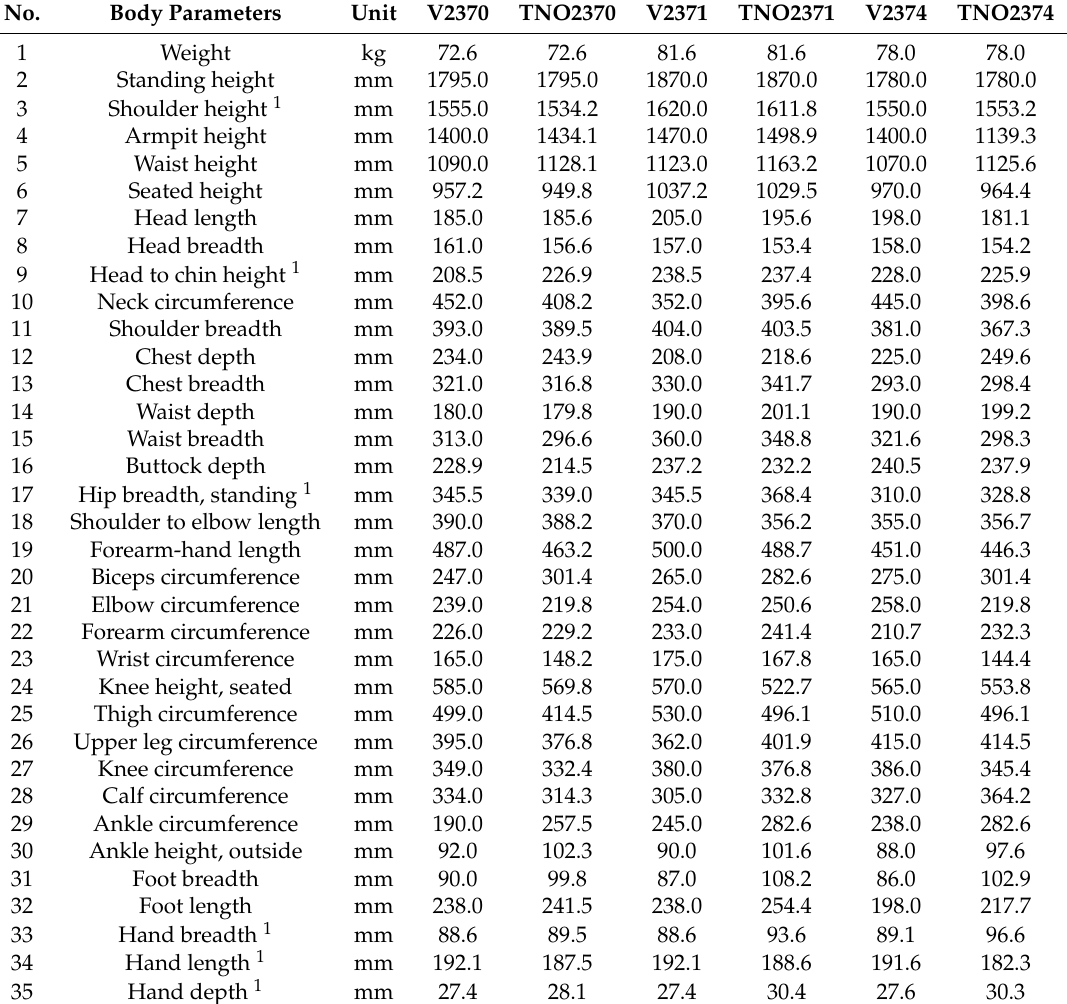
Table 2. Subjects anthropometry parameters used to scale in